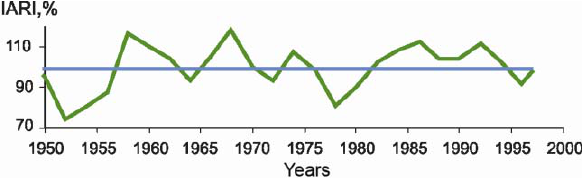
Fig. 4. Variation in the indexes of annual radial increment (IARI) of P. sylvestris in Pinetum myrtillo-sphagnosum during the period 1930–1997 by (Stravinskienė